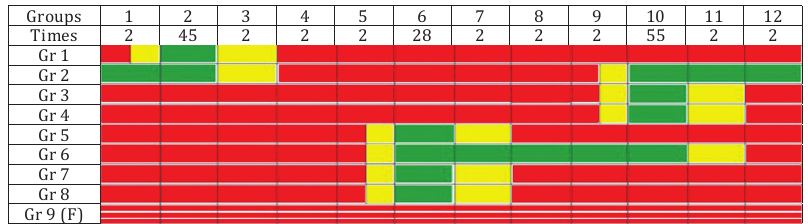
The signal plan for the proposed roundabout is given in Fig. 13. The intersection runs in a 4-phase system. In the first phase, the group 1 and 2 go green as shown in Fig. 9, in the second phase the group 5, 6, 7, 8 go green, and in the third phase the group 2, 3, 4, 6 go green. The group 9(F) shows the flashing red light in all phases. In the phase transitions, the yellow interval is 2 s when switching from green to red, red interval is 2 s and yellow-red interval is 2 s when switching from red to yellow.